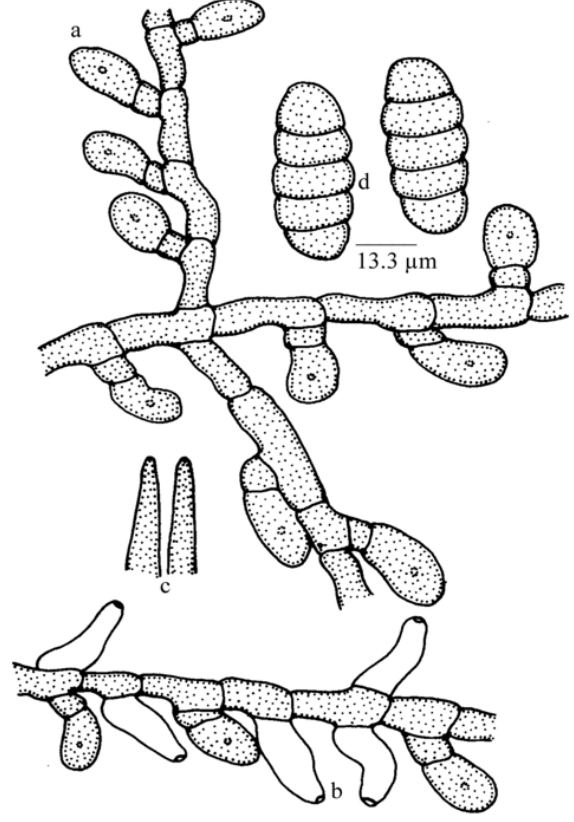
Figure 54. Meliola cannonicola a - Appressorium; b - Phialide; c - Apical portion of mycelial setae; d - Ascospores